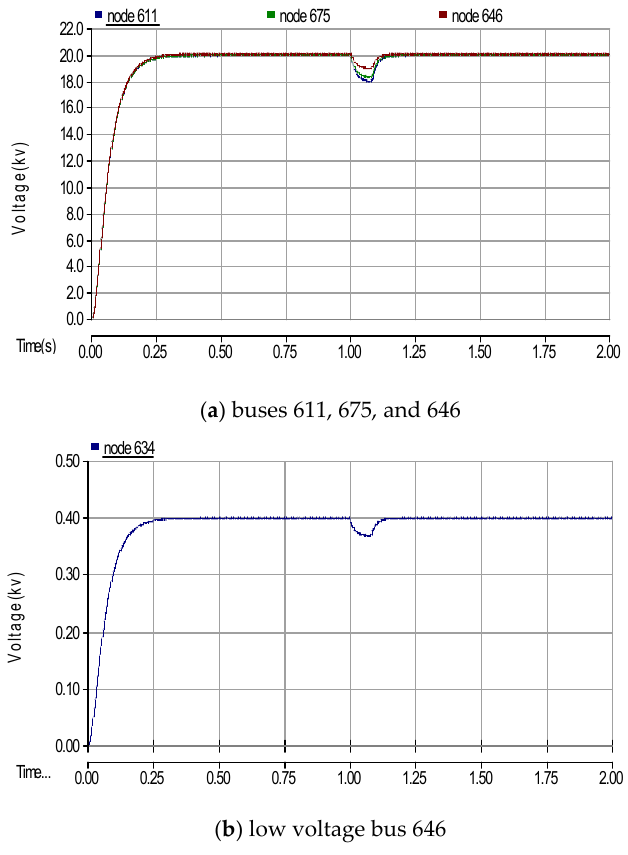
Figure 9. Comparison of voltage interruption due to three-phase to ground fault in bus 671 with DSTATCOM.